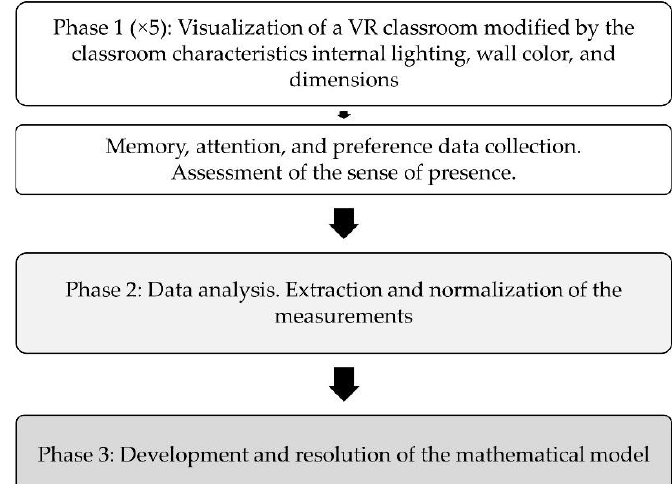
Figure 1. Schema of the study procedure.